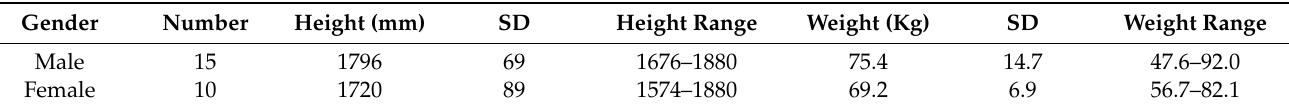
Table 3. Gender-specific mean, standard deviation (SD), and range of height and weight.